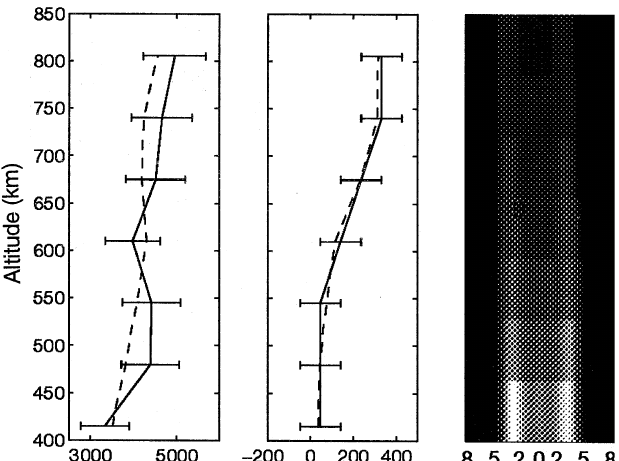
Fig. 3. Calculated electron temperatures from the ion acoustic frequency ( solid line ) and from the classical analysis ( dashed line ) at 1330:10 UT ( left ). Calculated ion vertical drift from the ion acoustic frequency ( solid line ) and classical analysis ( dashed line ) ( middle ). Color-coded spectra normalized to the maximum value ( right ) Fig. 4. Same as Fig. 3 at